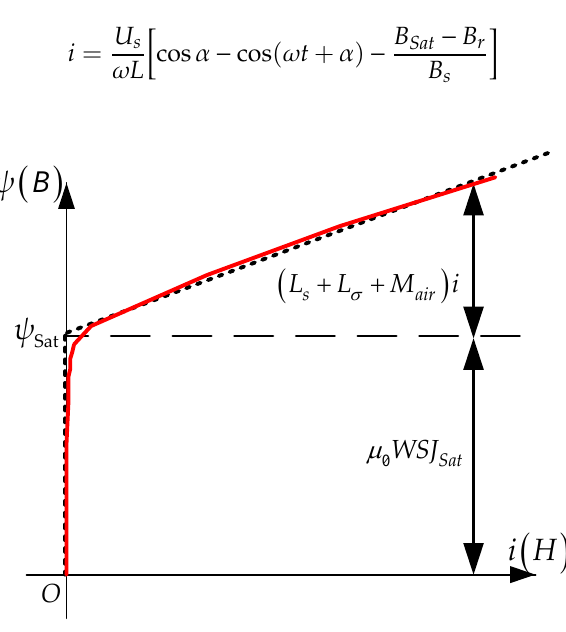
Figure 1. Magnetizing characteristic curve.